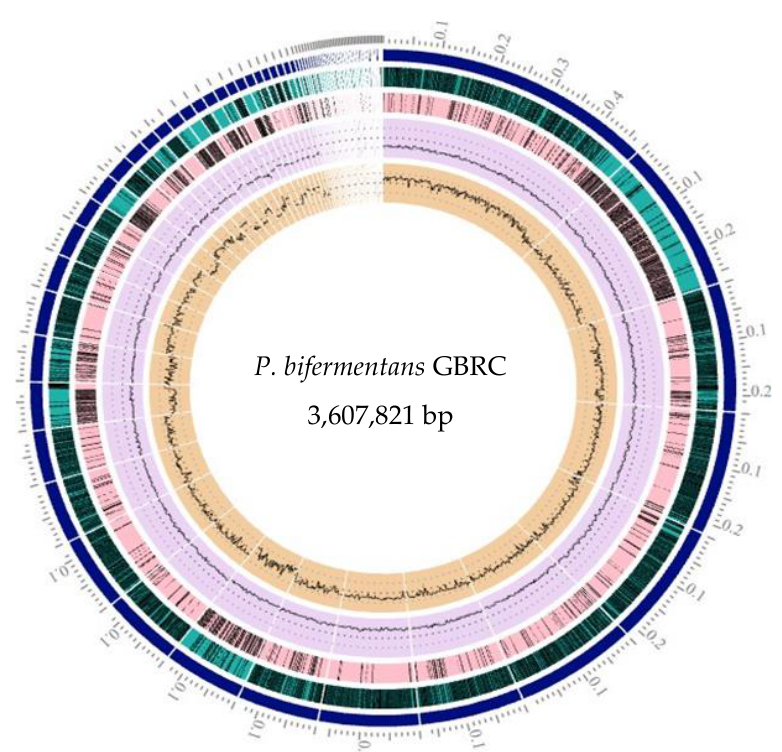
Figure 1. Graphical circular representation of the genome of the strain GBRC circles from interior to exterior represent GC skew, GC content, CDS on reverse strand, and CDS on forward strand.